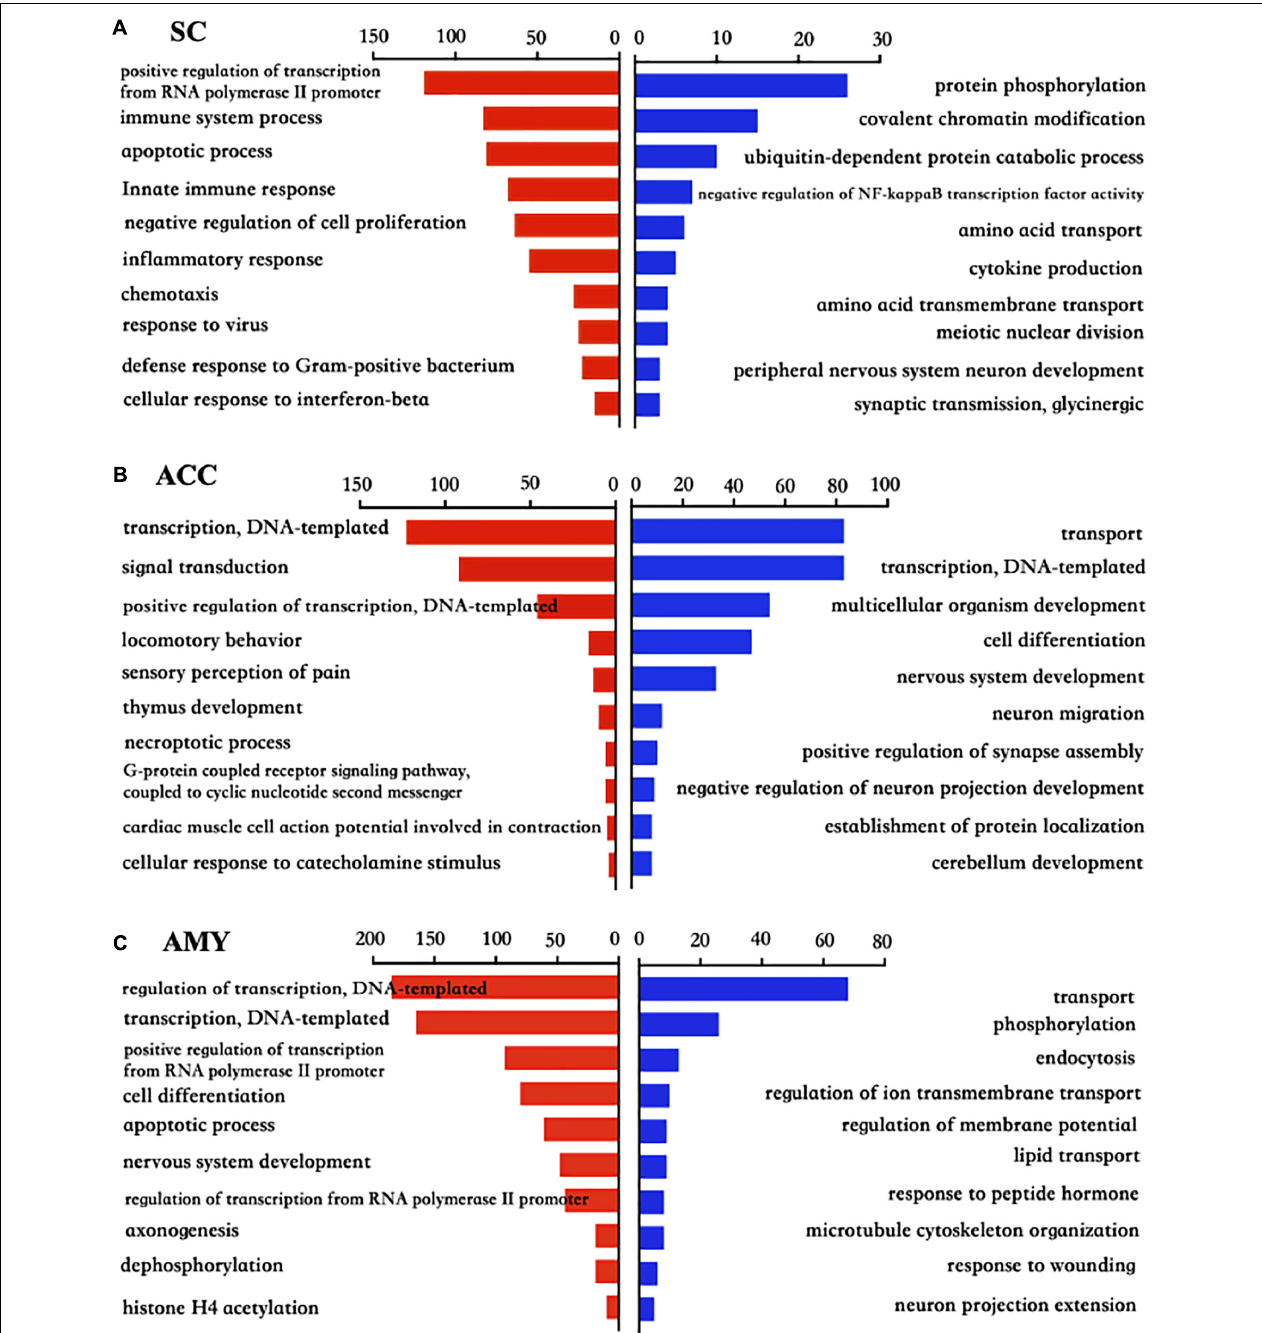
FIGURE 5 | Biological process analysis of the differentially expressed up- and downregulated mRNAs in the SC, ACC, and AMY after nerve injury. (A–C) Analysis of the Gene Ontology database showed top 10 biological processes from upregulated mRNAs (red panels on the left) and downregulated mRNAs (blue panels on the right) in the SC (A) , ACC (B) , and AMY (C) on day 7 post-SNL according to the P -value. The DAVID database was used to do the GO enrichment analysis. Red and blue bars represent up- and downregulated mRNA enrichments, respectively.